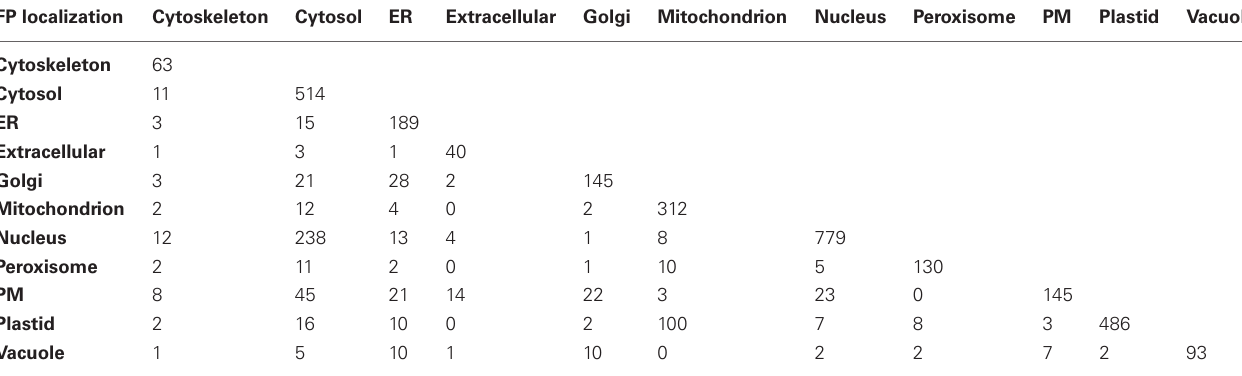
Table 2 | A paired matrix showing dual FP localization claims for each possible subcellular compartment combination. FP